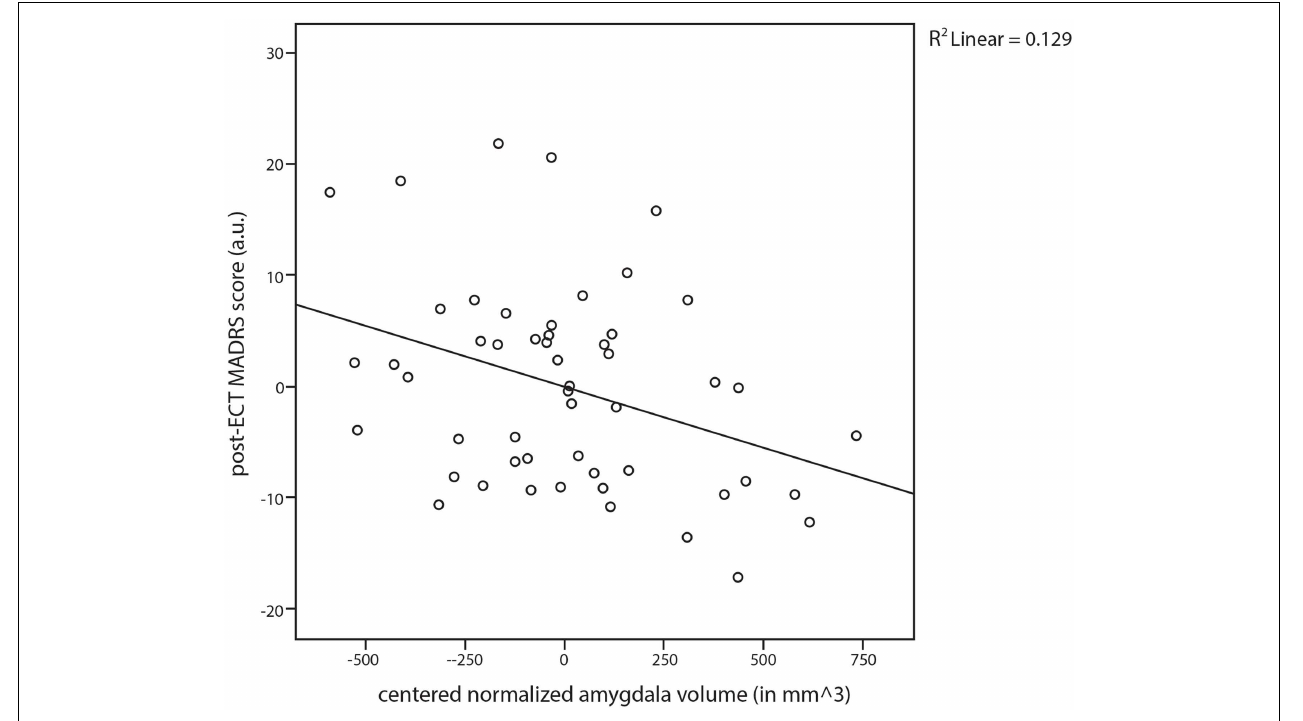
FIGURE 2 | Scatter plot and regression line for the post-electroconvulsive therapy (ECT) established Montgomery–Åsberg Depression Rating Scale (MADRS) scores against the normalized amygdala volume (amygdala volume/intracranial volume)